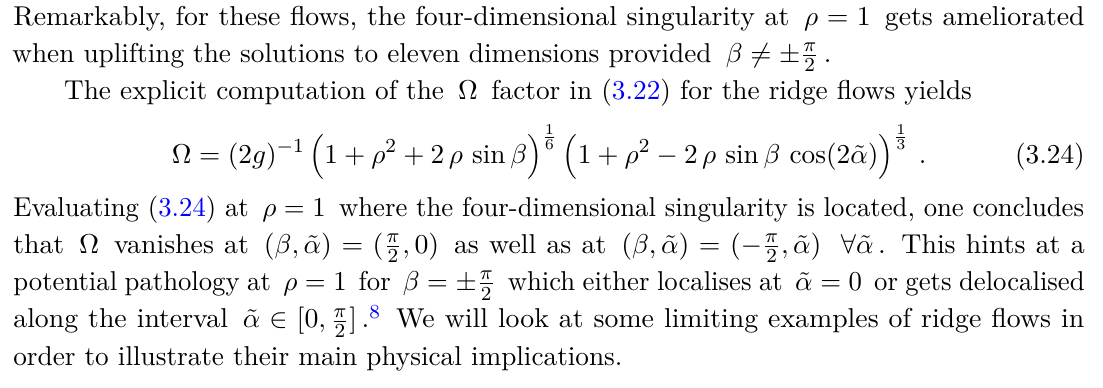
Figure 7 . Volume of the internal seven-sphere (orange dome) as a function of the complex scalar ˜ z . Examples of singular Hades flows are superimposed with ( α, β ) = (0 , 0) (green straight line), ( α, β ) = (0 , π ) (blue straight line), ( α, β ) = (0 , − π ) (red straight line), ( α, λ ) = (2 , π 2 2 line) and ( α, λ ) = (2 , − π ) (red curved 2